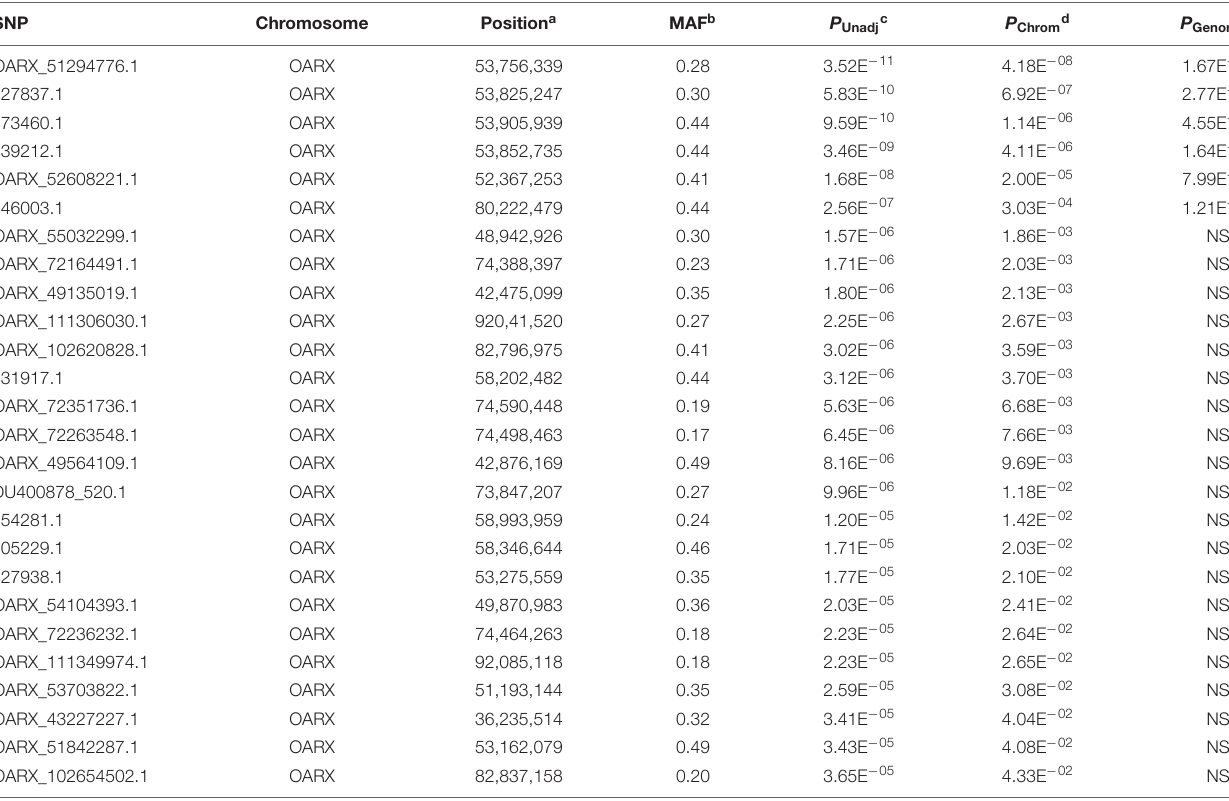
TABLE 1 | Markers significantly associated with litter